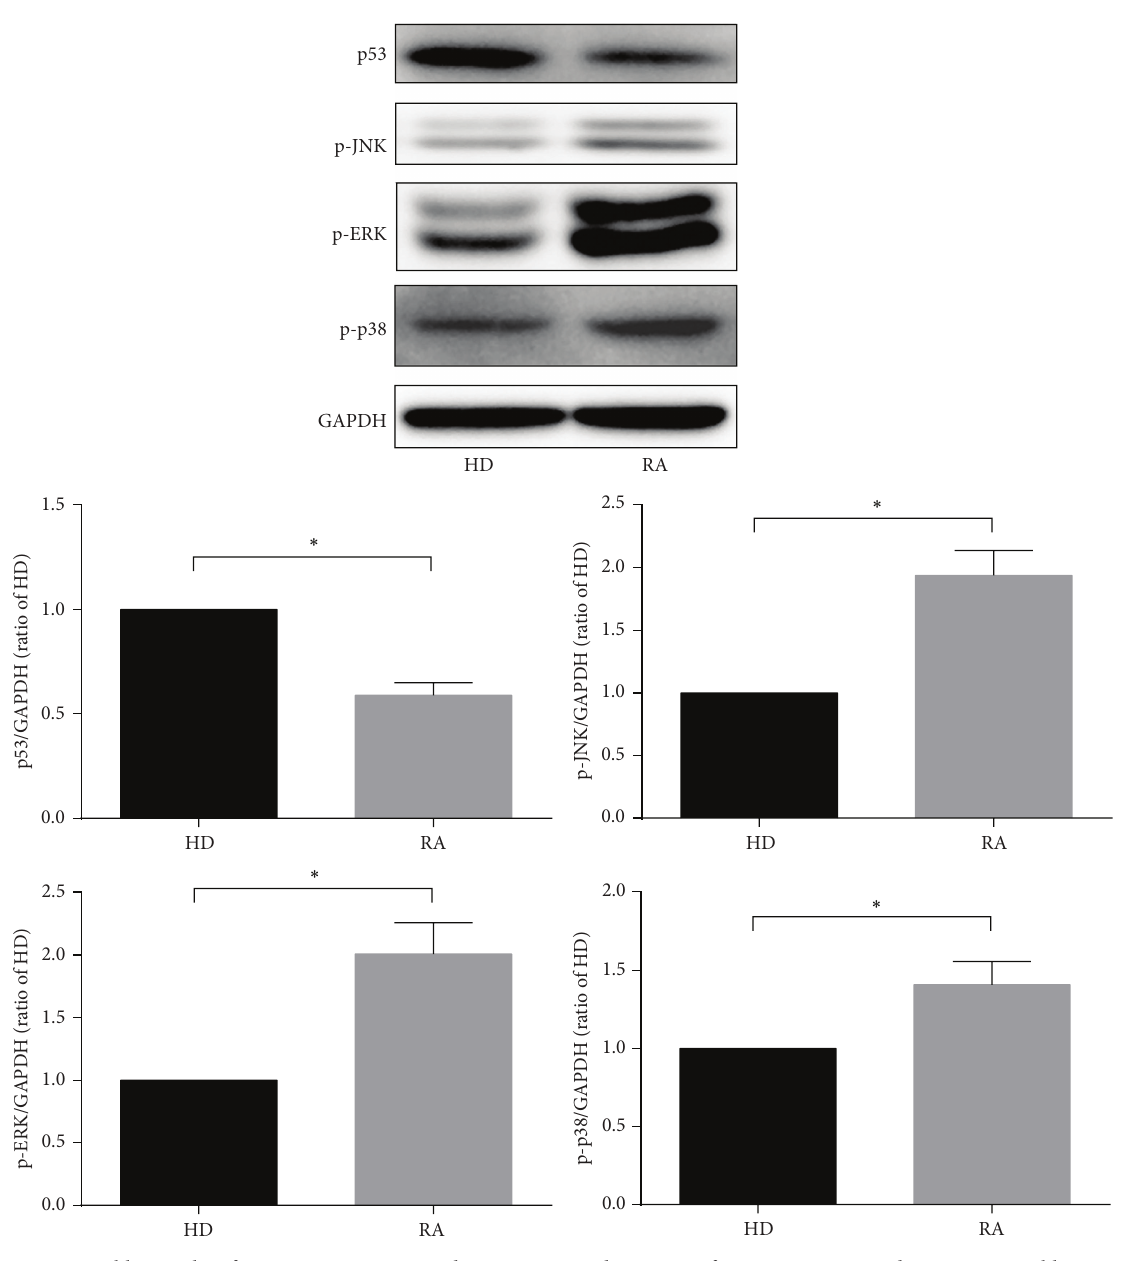
Figure 6: Western blot results of p53, p-JNK, p-ERK, and p-p38 expressed in SMSCs from RA patients and HDs. Western blot was used to determine the levels of p53 expression in the p53 pathway and p-JNK, p-ERK, and p-p38 expression in the MAPK signaling pathway. The internal marker protein GAPDH was used for normalization. ∗ 𝑃 < 0.05